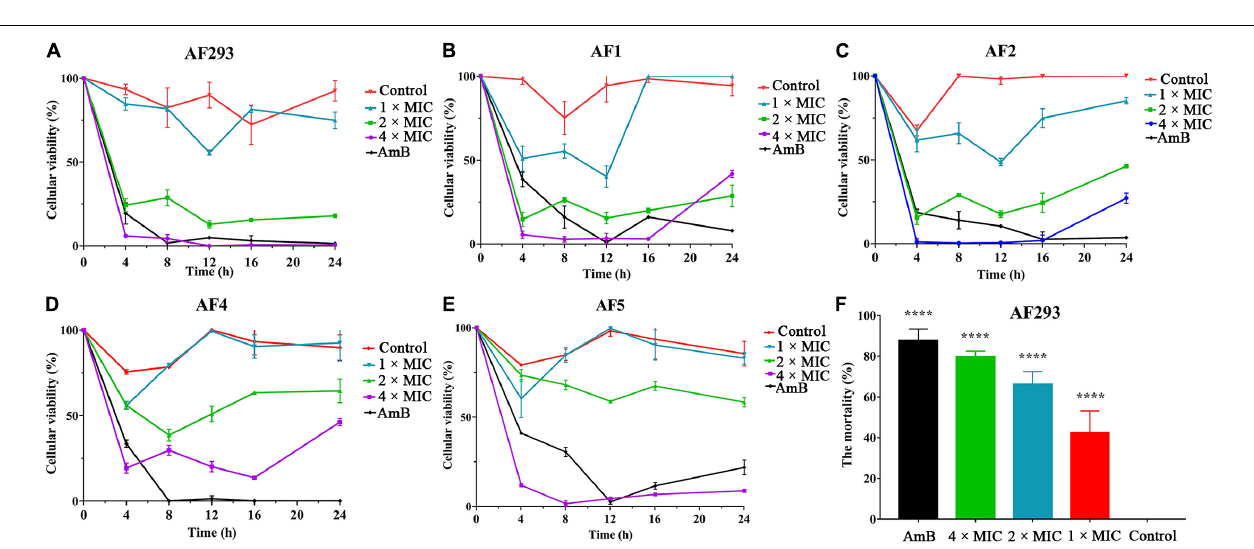
FIGURE 3 | Effect of sodium new houttuyfonate (SNH) on conidial generation. (A) Generation of A. fumigatus treated with SNH. (B–F) A. fumigatus germination number counted after 1 × , 2 × , or 4 × MIC SNH treatment at 37 ◦ C for 12, 16, and 20 h. Testing of each group was performed in triplicate, and the level of statistical significance was set at * P < 0.05. The number of A. fumigatus germinations was counted under a microscope (400 × ).